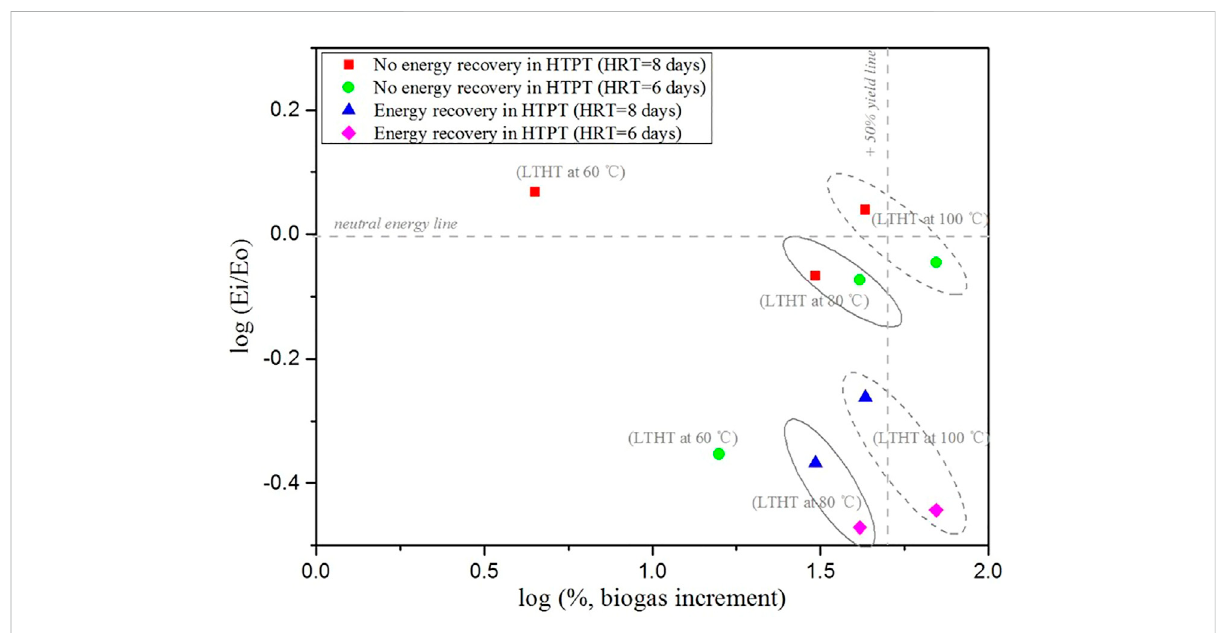
FIGURE 5 Energy balance of all the treatments and the related increment in biogas